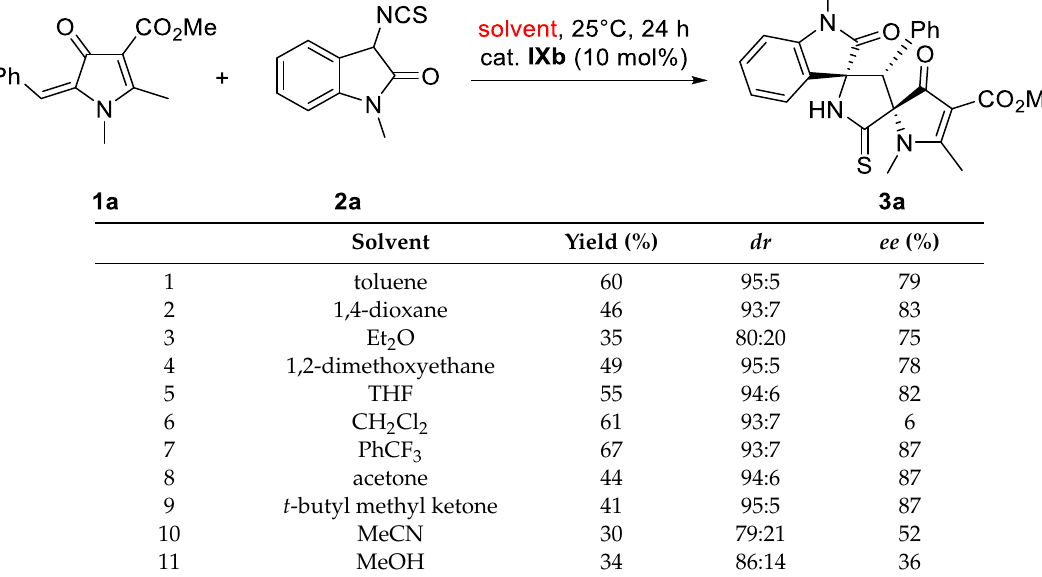
Table 1. Evaluation of organocatalyst IXb in bis-spiroheterocyclization of 5-arylidene-Δ 2 -pyrrolin-4-one 1a with 3-isothiocyanatooxindole 2a. a